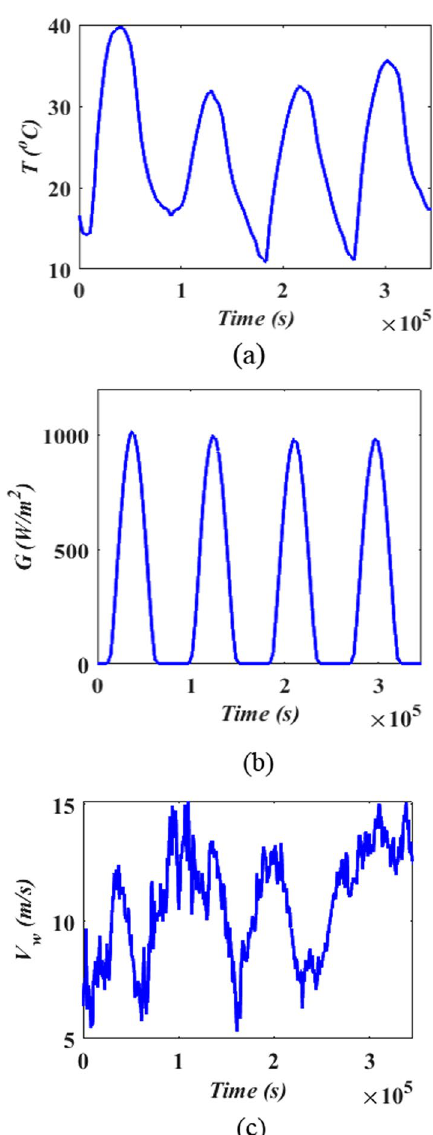
Fig. 13 Real weather conditions at Zafarana a T , b G , c V w